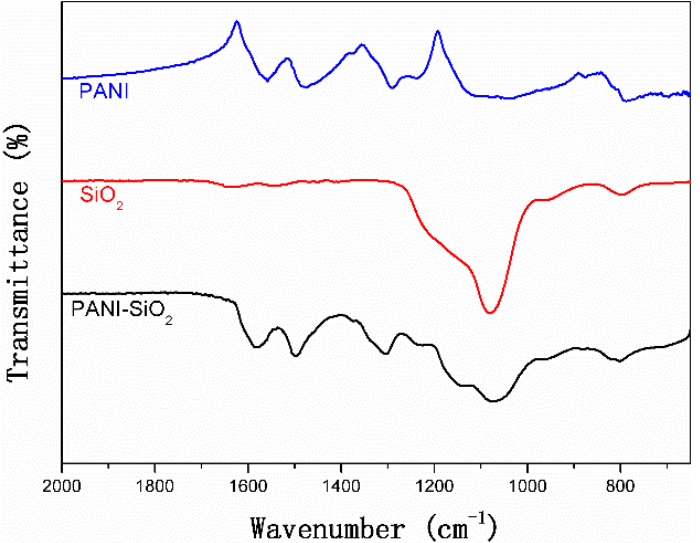
Figure 1. FTIR spectra of bulk polyaniline (PANI), mesoporous silica and